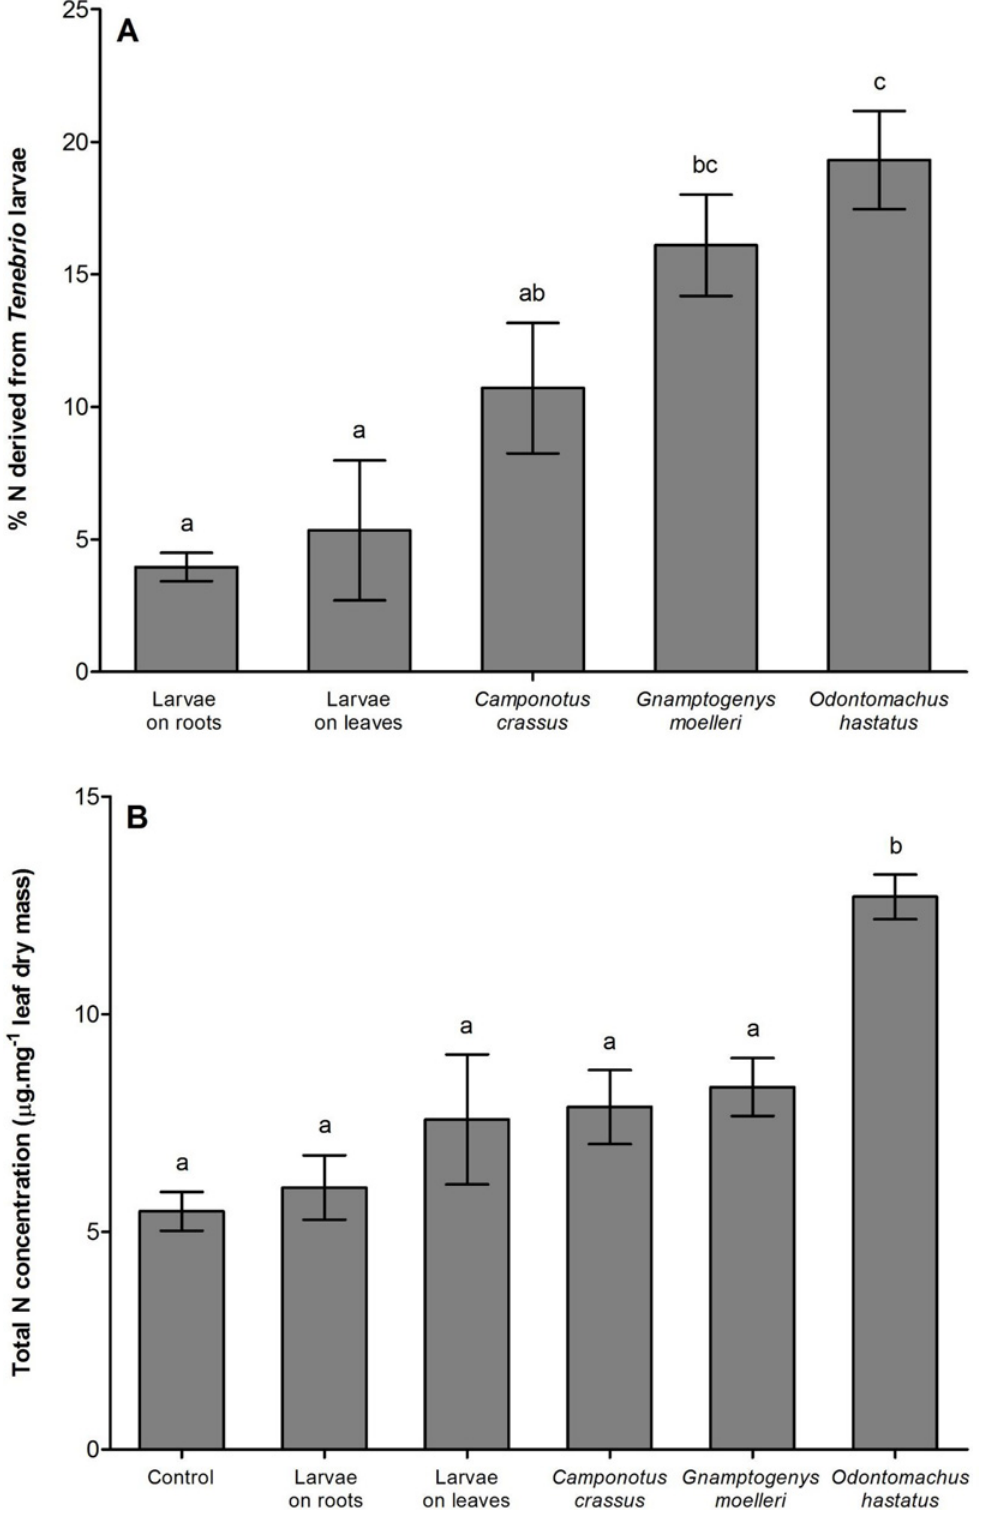
Fig 1. Percentage of nitrogen derived from prey and total nitrogen concentration of bromeliads. (A) Percentage of nitrogen derived from Tenebrio larvae and (B) total nitrogen concentration of Quesnelia arvensis leaves of different treatments (control; Tenebrio among roots; Tenebrio on leaves; Camponotus crassus ants and Tenebrio ; Gnamptogenys moelleri and Tenebrio ; and Odontomachus hastatus and Tenebrio ). Bars indicate the standard error and letters indicate Tukey post-hoc test ( α < 0.05).